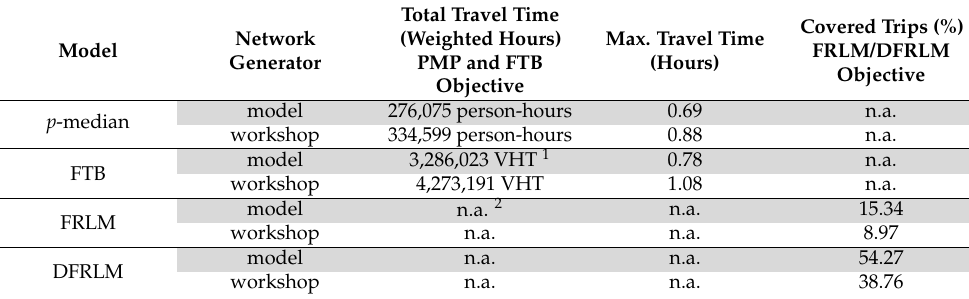
Table 8. Comparison of model and workshop coverage results for 5 stations.